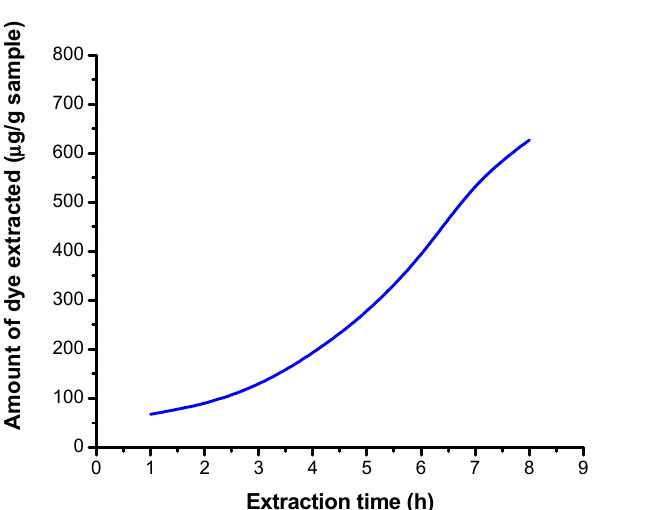
Figure 12. Dependence of the extracted 5% dye concentration on the extraction time in a neutral environment.